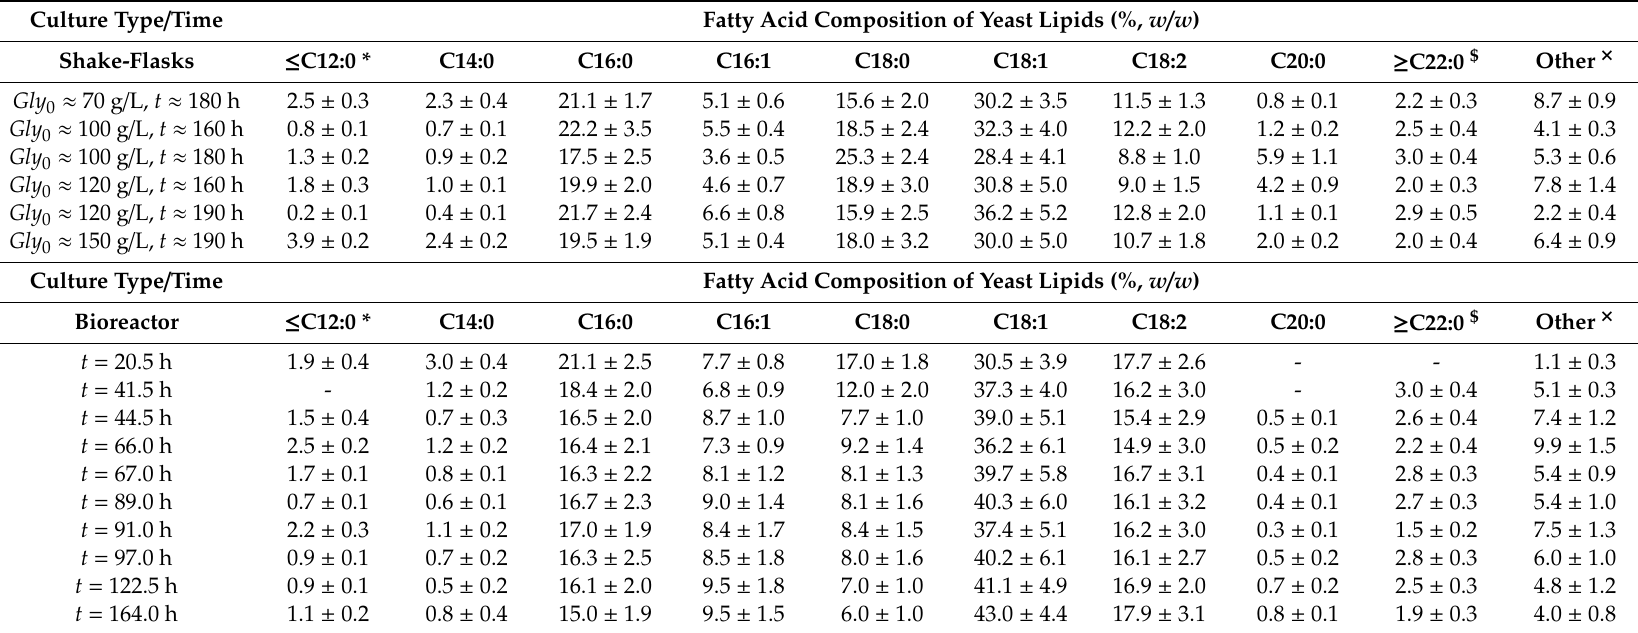
Table 6. Fatty acid composition of the cellular lipids produced by Yarrowia lipolytica LMBF Y-46 cultivated on glycerol in shake-flask, batch and fed-batch bioreactor experiments. Each experimental point presented is the mean value of two independent determinations. Culture conditions as in Tables 1 and